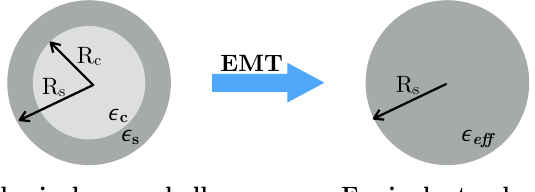
Figure 2. Scheme of the effective medium problem for a spherical nano-shell: a coated sphere of radius R s formed by a core –dielectric function (cid:101) c and radius R c – and a shell –dielectric function (cid:101) s – is reduced to a homogeneous sphere –radius R s – applying an effective medium theory (EMT) to calculate its effective dielectric function (cid:101) ef f